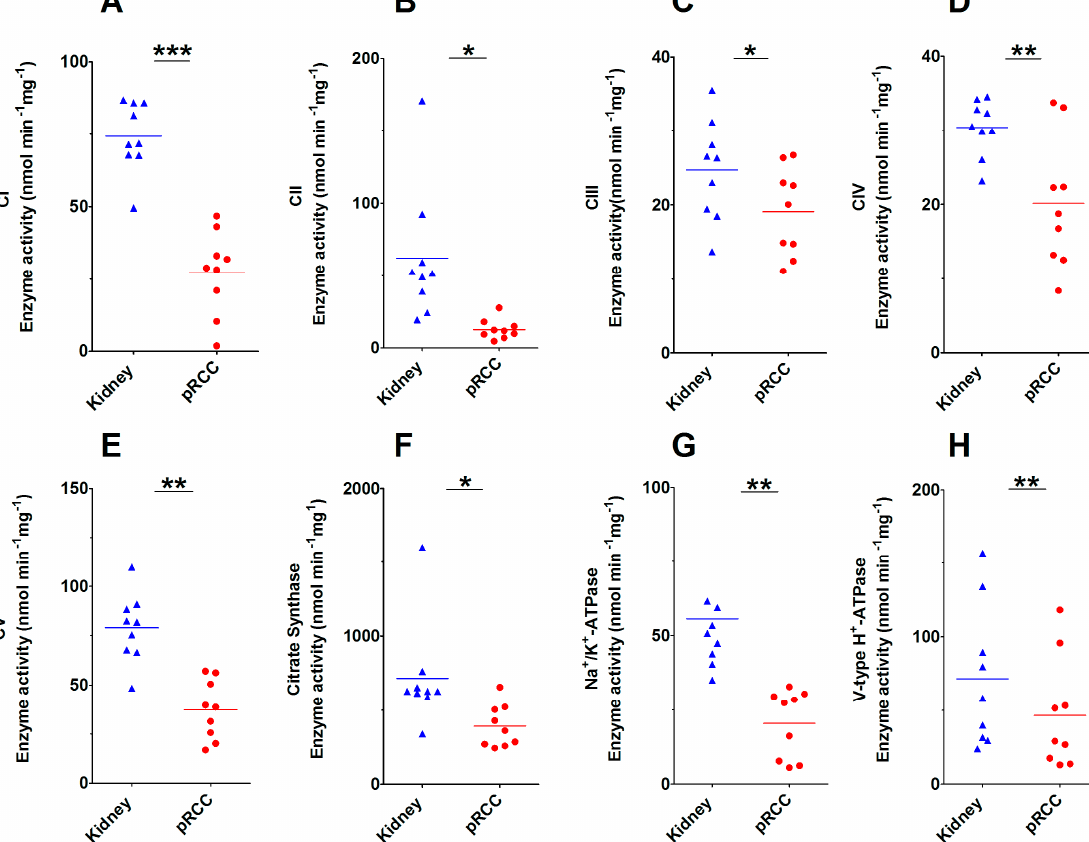
Figure 4. Enzymatic activities of the respiratory chain, F 0 F 1 ATPases, citrate synthase, and the P- and V- ATPases in papillary renal cell carcinoma (pRCC) versus kidney control tissues. ( A ) Complex I (CI), ( B ) Complex II (CII), ( C ) Complex III (CIII), ( D ) Complex IV (CIV), ( E ) F 0 F 1 ATPase (CV), ( F ) Citrate synthase (CS), ( G ) P-ATPases, ( H ) V-ATPases. P-values are: * p < 0.05, ** p < 0.01, and *** p < 0.001 by a paired t-test; nmol min/mg protein. n = 3 for each type I, II, and IIM.